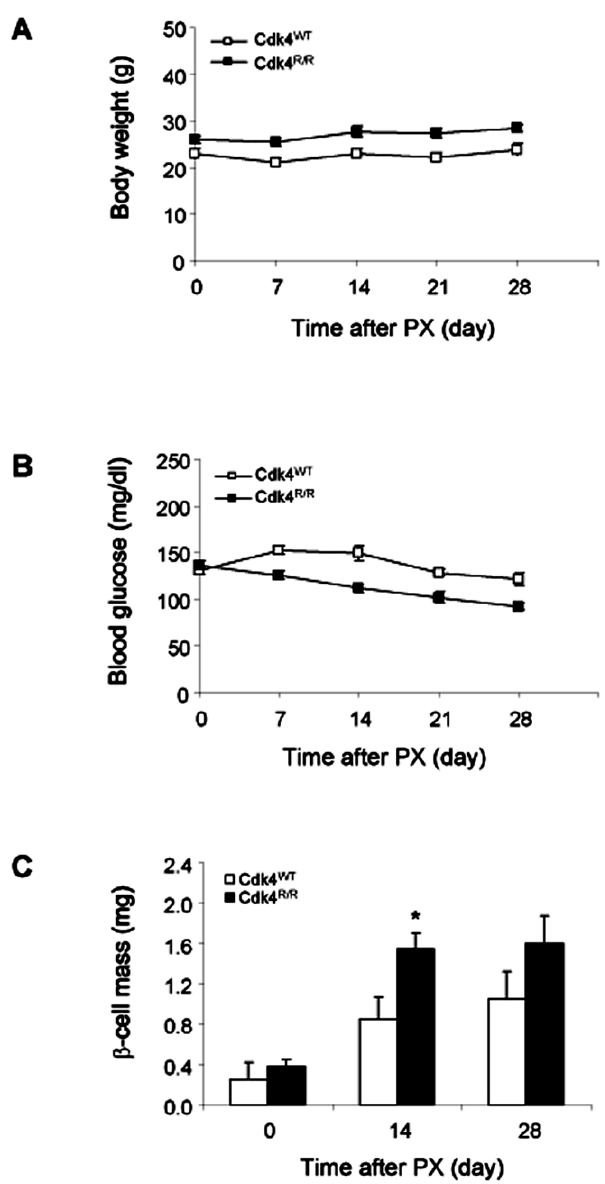
Figure 1. Enhanced regeneration of b -cell mass in Cdk4 R/R mice in response to partial pancreatectomy (PX). (A) Body weight change and (B) fed-state blood glucose levels were measured before (day 0) and on indicated days after PX on Cdk4 WT mice (open squares) and Cdk4 R/R mice (closed squares). (C) b -cell mass is increased after PX in both groups. Significant increase of b -cell mass was observed in Cdk4 R/R mice (closed bars) compared with Cdk4 WT mice (open bars) by 14 days after PX. Data are shown as means and error bars represent S.E. * p , 0.05 vs Cdk4 WT mice.